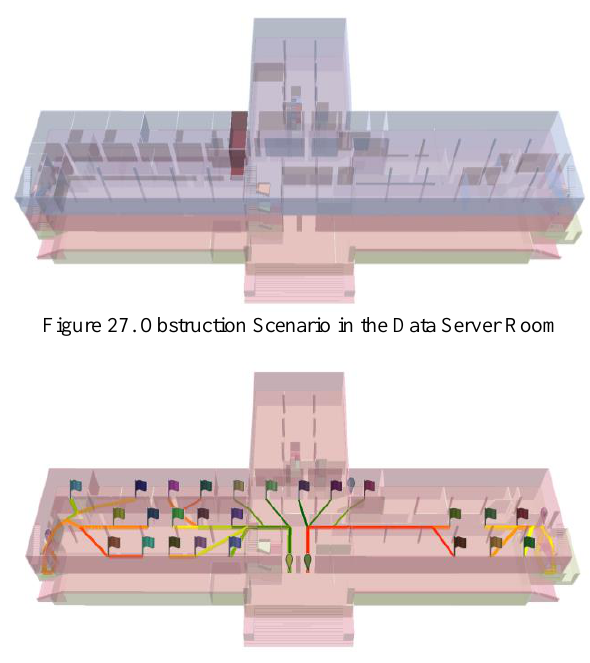
Figure 28. Generated Evacuation Second Floor Routes